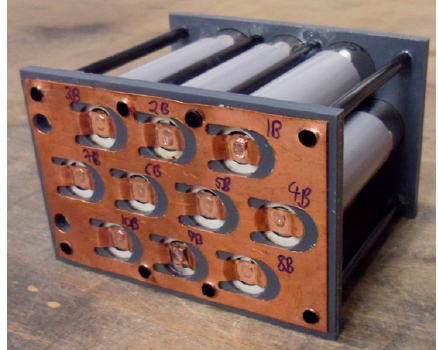
Figure 5. Supercell with 10 cylindrical cells.